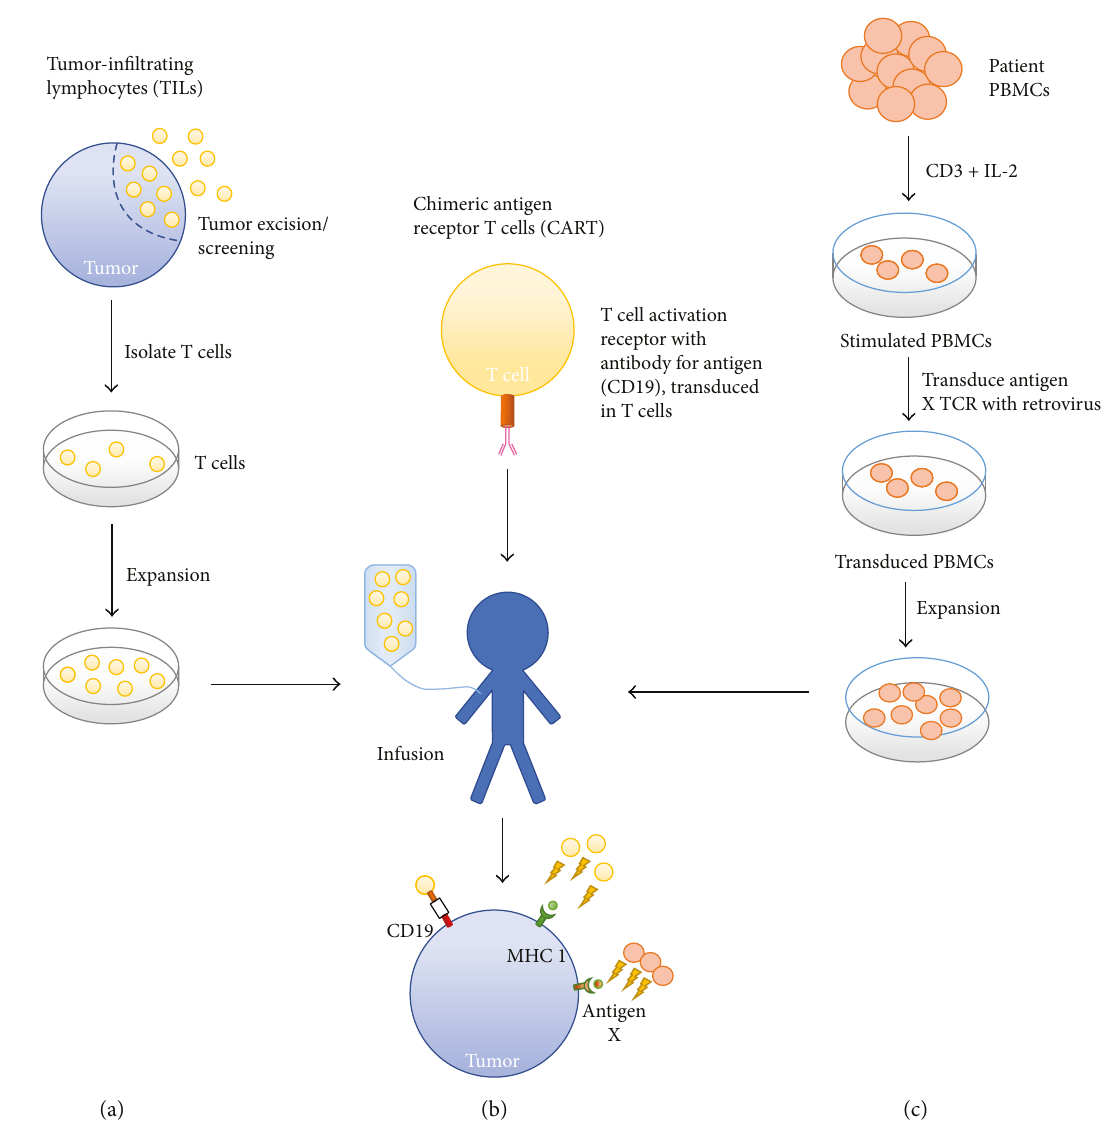
Figure 2: Procedure for adoptive T cell transfer with CAR T cells and TILs. Adoptive transfer of TILs and CAR T cells to target the MHC1 and CD19 antigen on a tumor cell, respectively. (a) Excision of the tumor followed by isolation and expansion of lymphocytes present from the excised tumor. Expanded cells are then infused into the patient. (b) Chimeric antigen receptor T cells are designed to target the CD19 antigen and are then infused into the patient. (c) TCR-transduced T cells are generated from patients ’ PBMC and stimulated with a retrovirus containing the antigen “ X ” -speci fi c